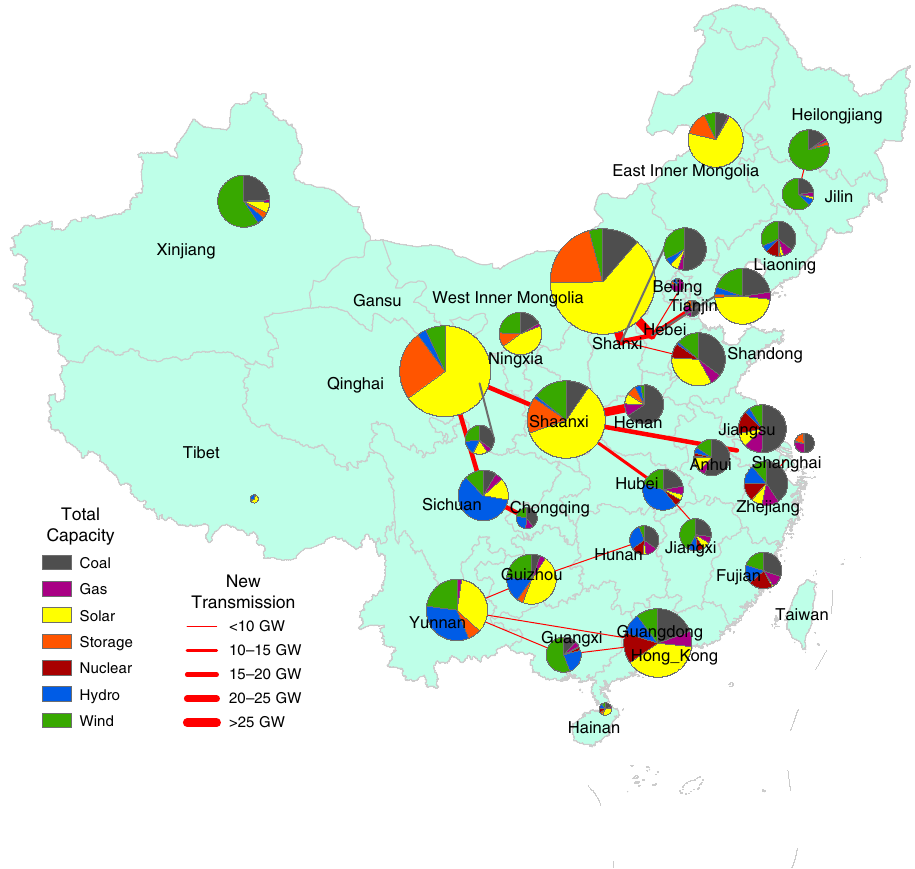
Fig. 6 Provincial total capacity mix and new transmission lines required by 2030 under the R scenario. The pie charts shows the total power capacity mix in each province, and the red lines show the new interprovincial transmission lines to bring electricity from resource centers to demand centers. Source data are provided as a Source Data fi